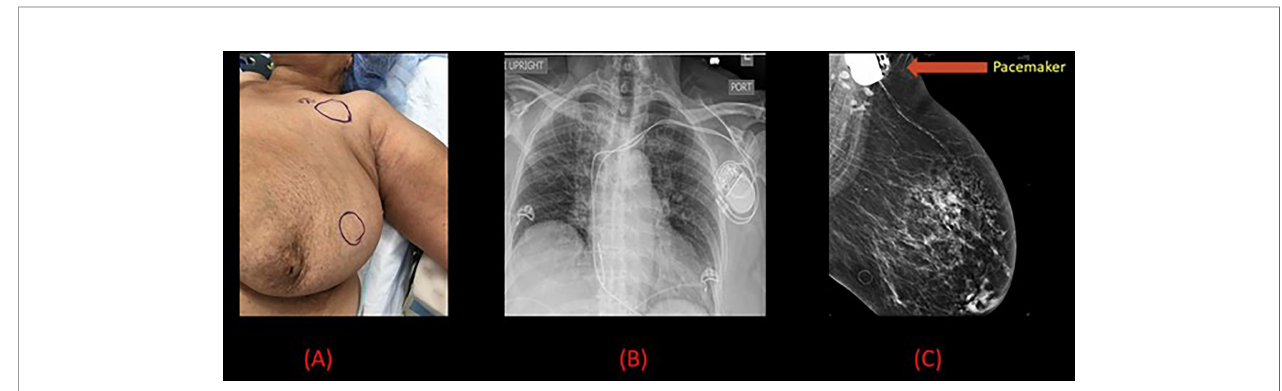
FIGURE 1 | Pre-operative and radiological images for patient 1. (A) Pre-operative image of the left breast with the location of the pacemaker marked by a circle in the superior portion close to the neck and the inferior circle indicates the presence of radiological seed. (B) Chest x-ray demonstrating left sided pacemaker with dual leads projecting over the right atrium and right ventricle. (C) Mammogram demonstrating a 10 mm spiculated mass in the left breast along with the